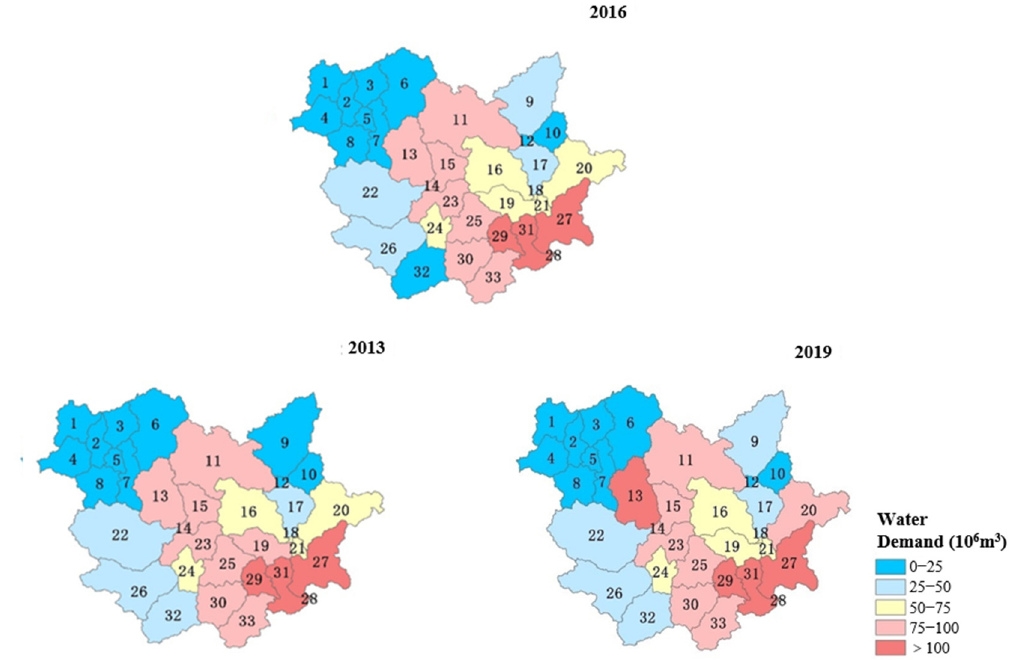
Figure 10. Spatial distribution of water demand in the Jinjiang watershed in 2013, 2016, and 2019.